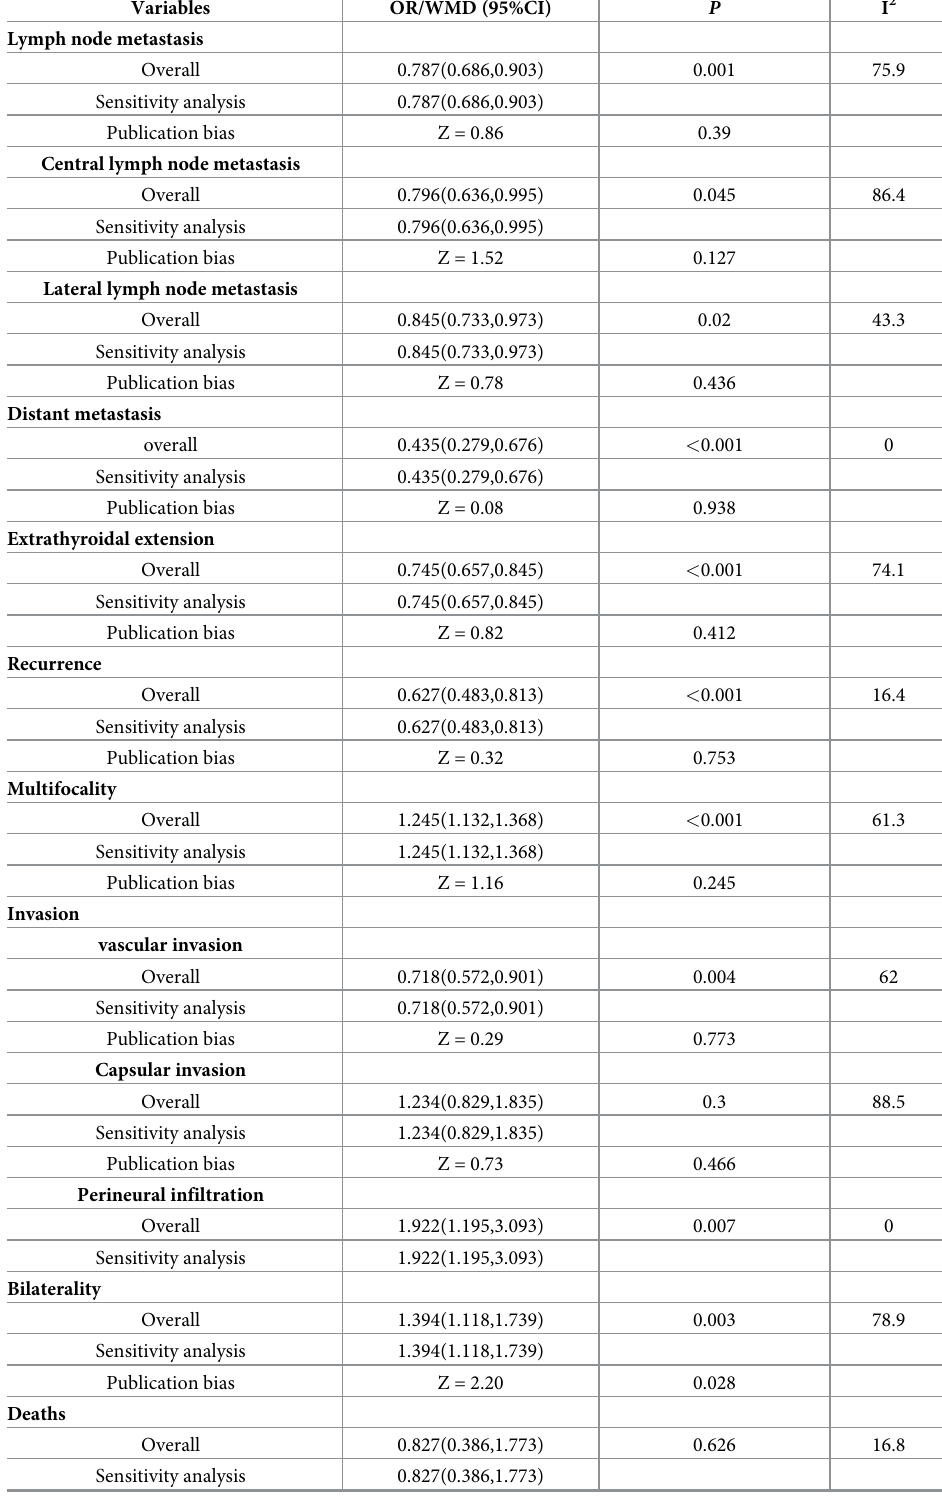
Table 2. Overall and sensitivity analysis